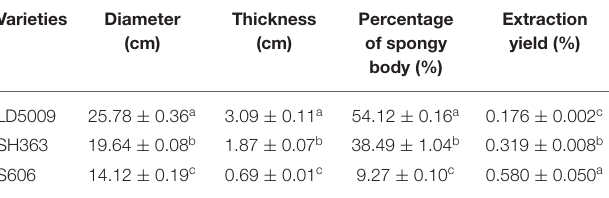
TABLE 4 | The morphological characters and the extraction yields of SEOs from different varieties of sunflowers. Varieties Diameter